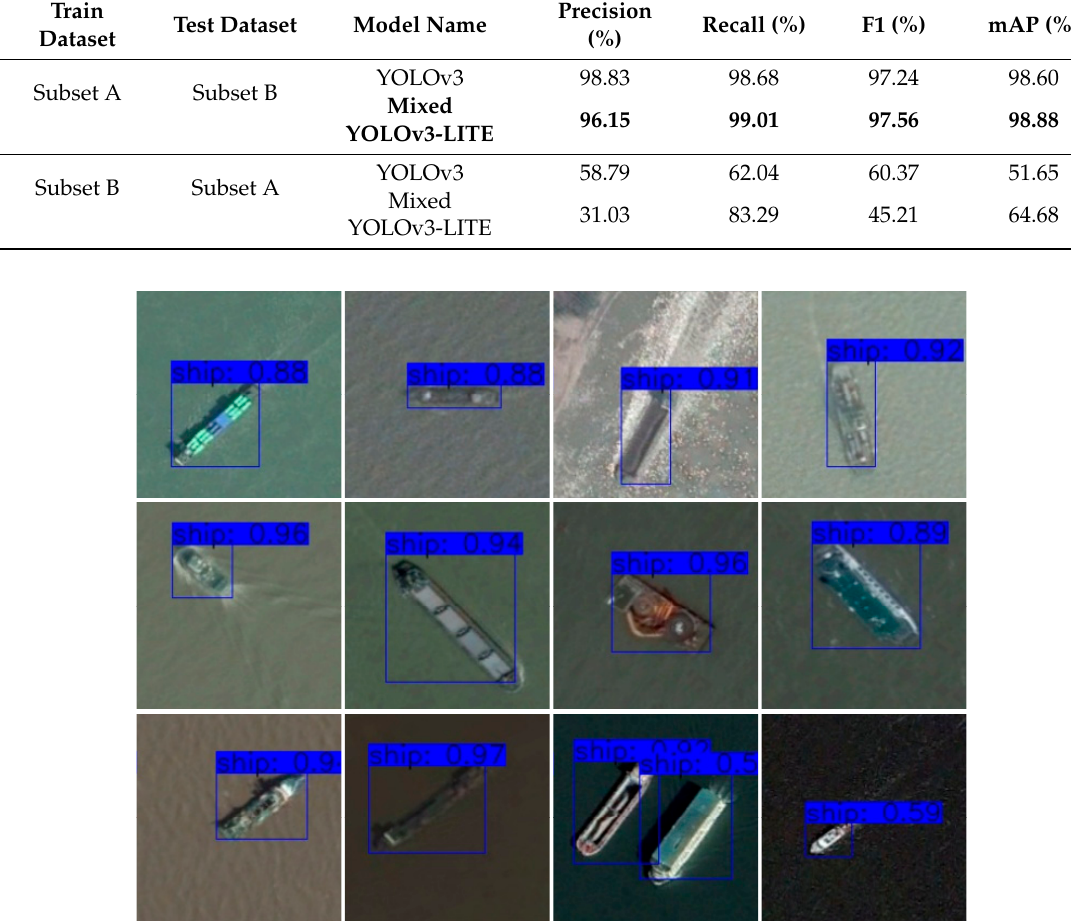
Figure 9. Partial test results for Mixed YOLOv3-LITE for ShipData.